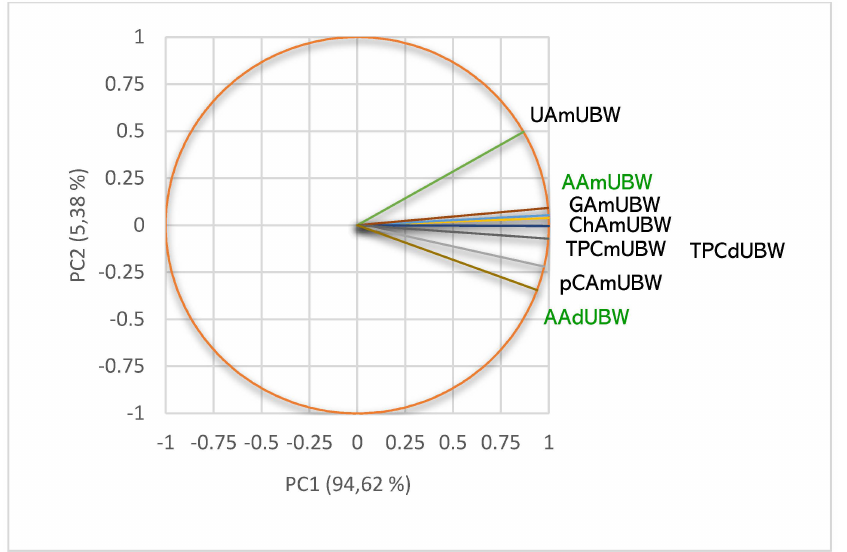
Figure 10. PCA-Correlation circle between TPC, UA, and individual polyphenols in m UBW and only between TPC in d UBW and antiradical activities; UBW— U. barbata water extract, m —macerate,